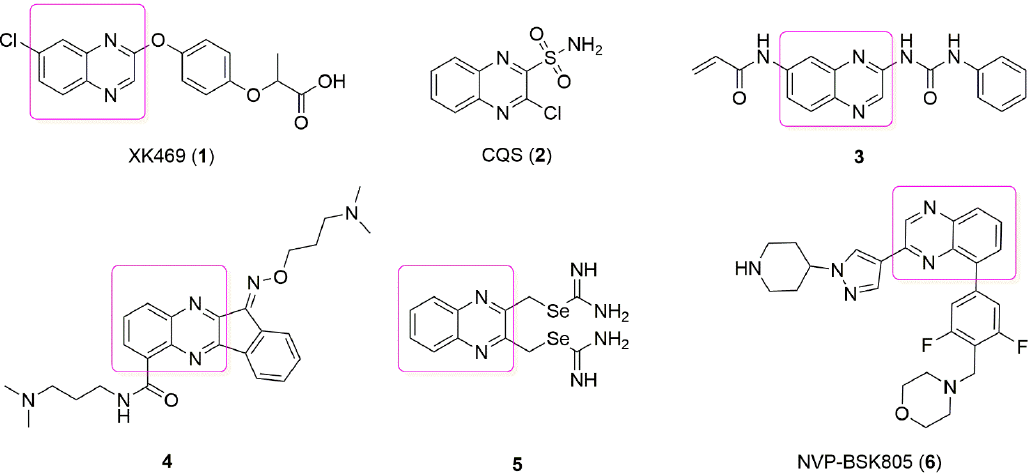
Figure 1. Chemical structures of representative quinoxaline antitumor agents.